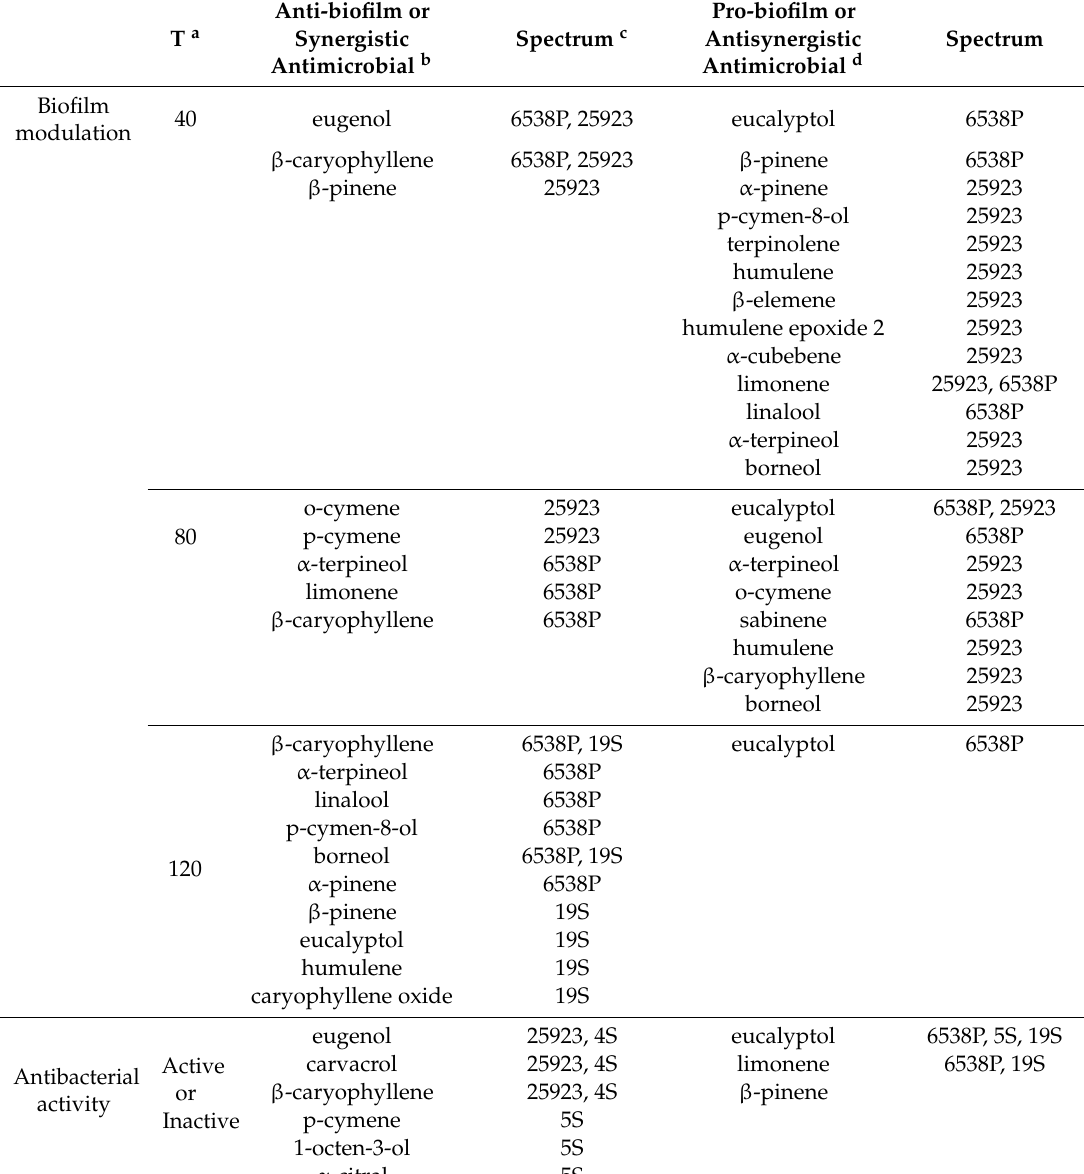
Table 3. Summary on the ML predicted essential oils’ (EO) single compounds influence on biofilm modulation and antibacterial activity. Compounds with an absolute value of FWI higher than 5 are